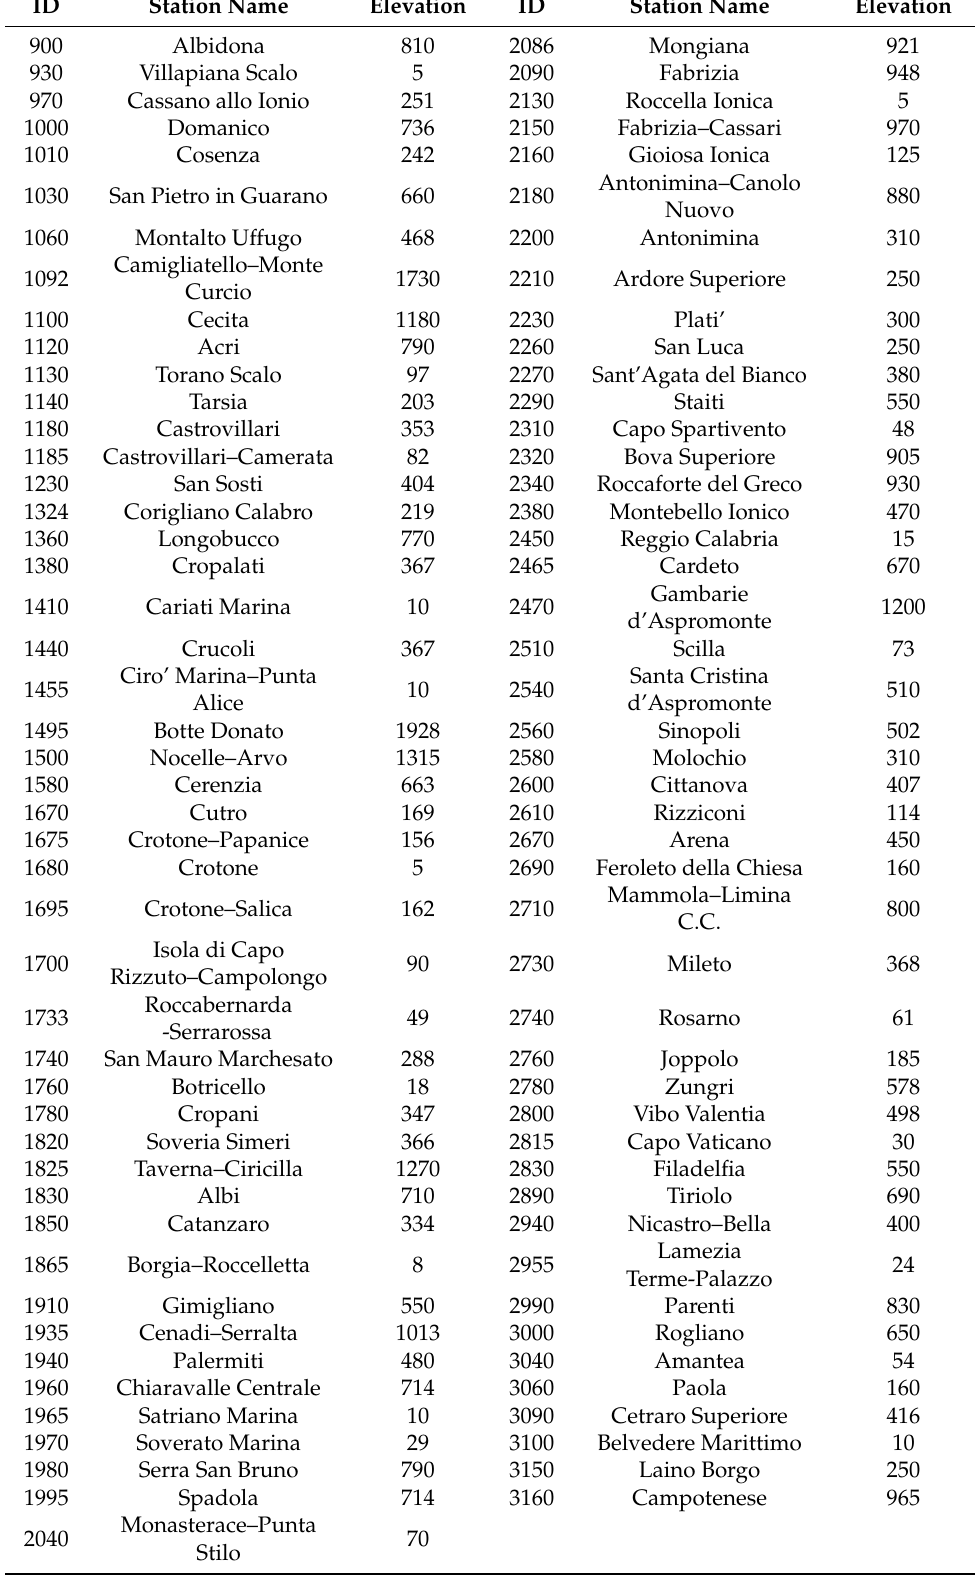
Table 1. Weather stations used in the study, with indication of ID and elevation (m